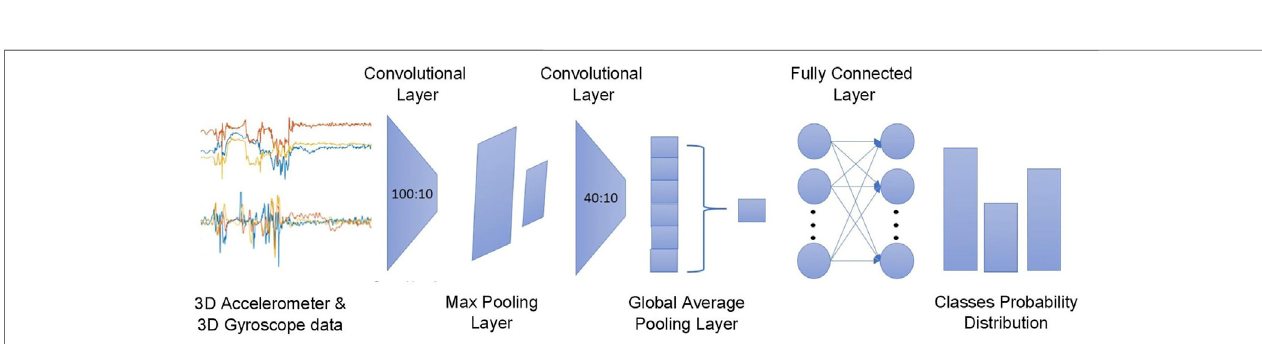
FIGURE 3 | The proposed CNN architecture where the triaxial accelerometer and gyroscope streams are processed via a two-layer 1D convolution layer with six channels outputting the predictions regarding the probable outcomes.